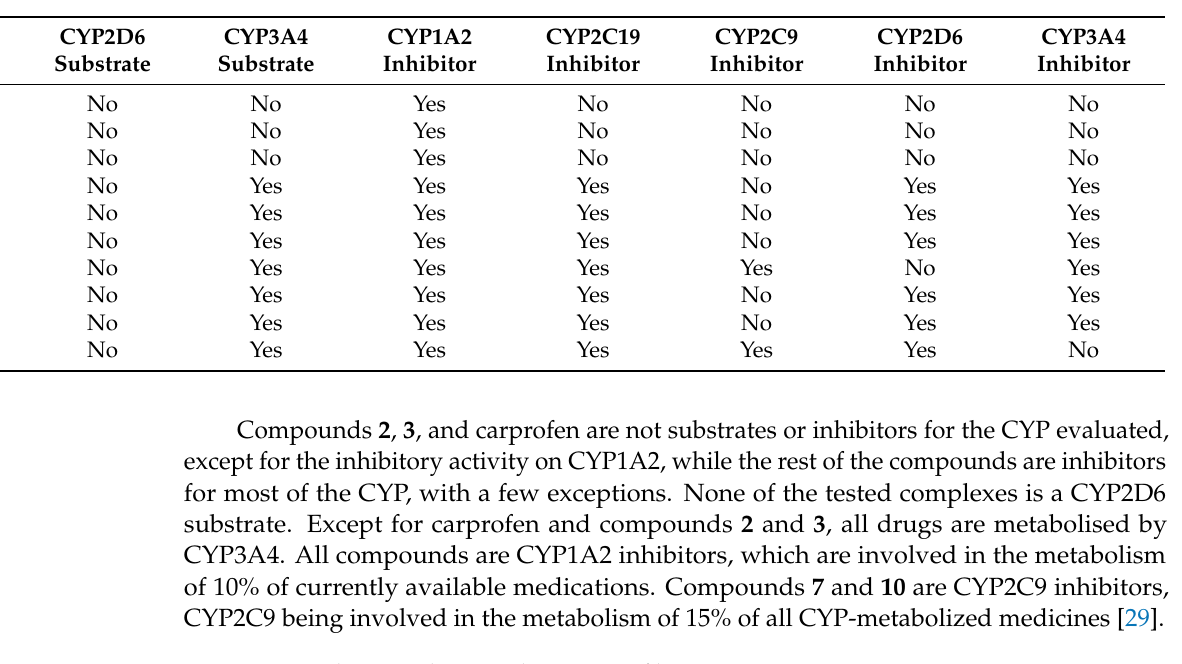
Table 6. Carprofen and compounds 2 – 10 pharmacogenomic profile targeting CYP2D6, CYP3A4, CYP1A2, CYP2C19, and CYP2C9.